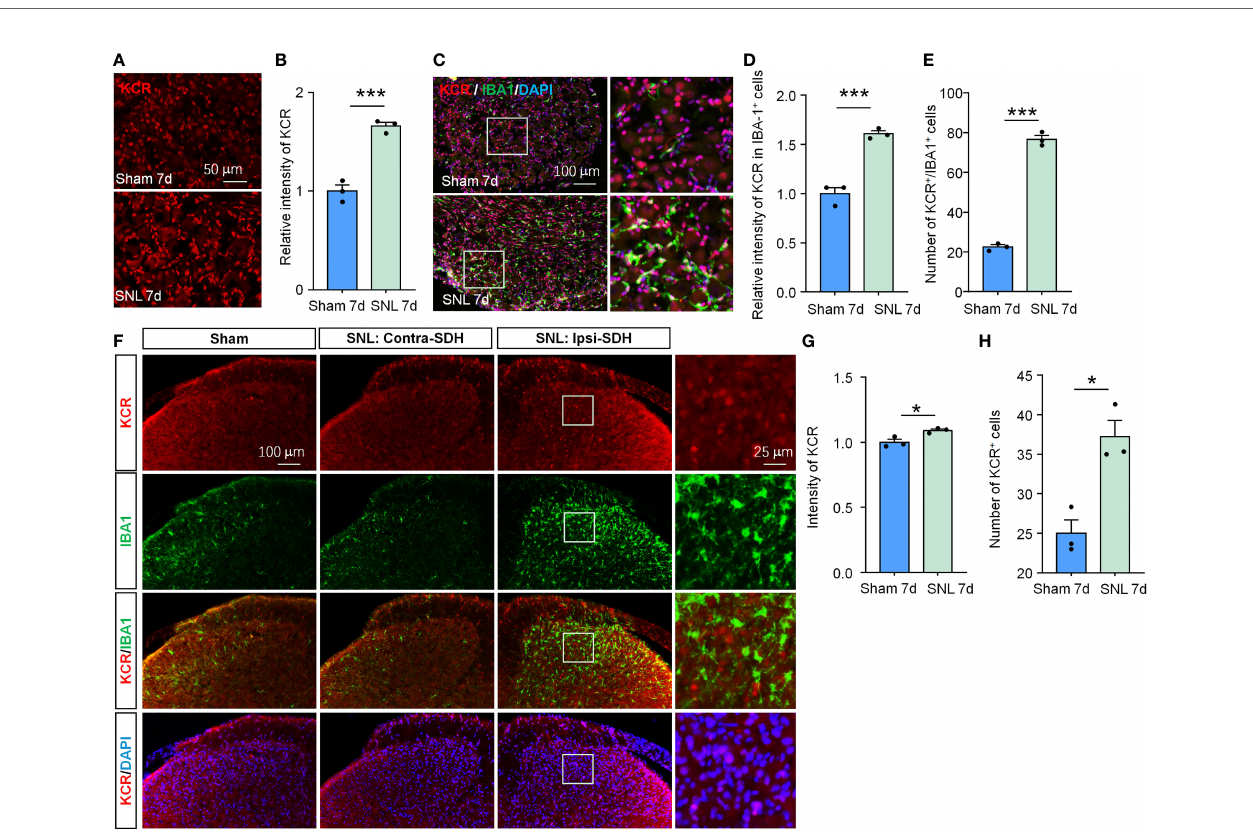
FIGURE 6 | SNL upregulated KCR levels in DRG and spinal cord. (A, B) Quanti fi cation of the total fl uorescence intensity of KCR in sham and SNL DRGs 7 days after surgeries. *** P <0.001, n = 3 mice per group, 3 sections per mice, student ’ s t-test. (C) Representative DRG sections labeled for DAPI, IBA-1 and KCR from sham and SNL groups. Scale bar = 100 m m. (D, E) Bar diagram showing KCR intensity in IBA-1 positive cells (D) and the number of KCR and IBA-1 double-positive cells (E) . *** P <0.001, n = 3 mice per group, 3 sections per mice, student ’ s t-test. (F) Representative images labeled for KCR, IBA-1, and DAPI in ipsilateral spinal cords of sham mice or in ipsilateral (SNL: Ipsi-SDH) and contralateral (SNL: Contra-SDH) spinal cords of SNL mice 7 days post-surgeries. The rightmost images are the magni fi cation of the white boxes in the SNL: Ipsi-SDH group. (G, H) Quanti fi cation of the total fl uorescence intensity (G) and number (H) of KCR in sham- and SNL-spinal dorsal horns seven days after surgeries. * P <0.05, n = 3 mice per group, 3 sections per mice, student ’ s